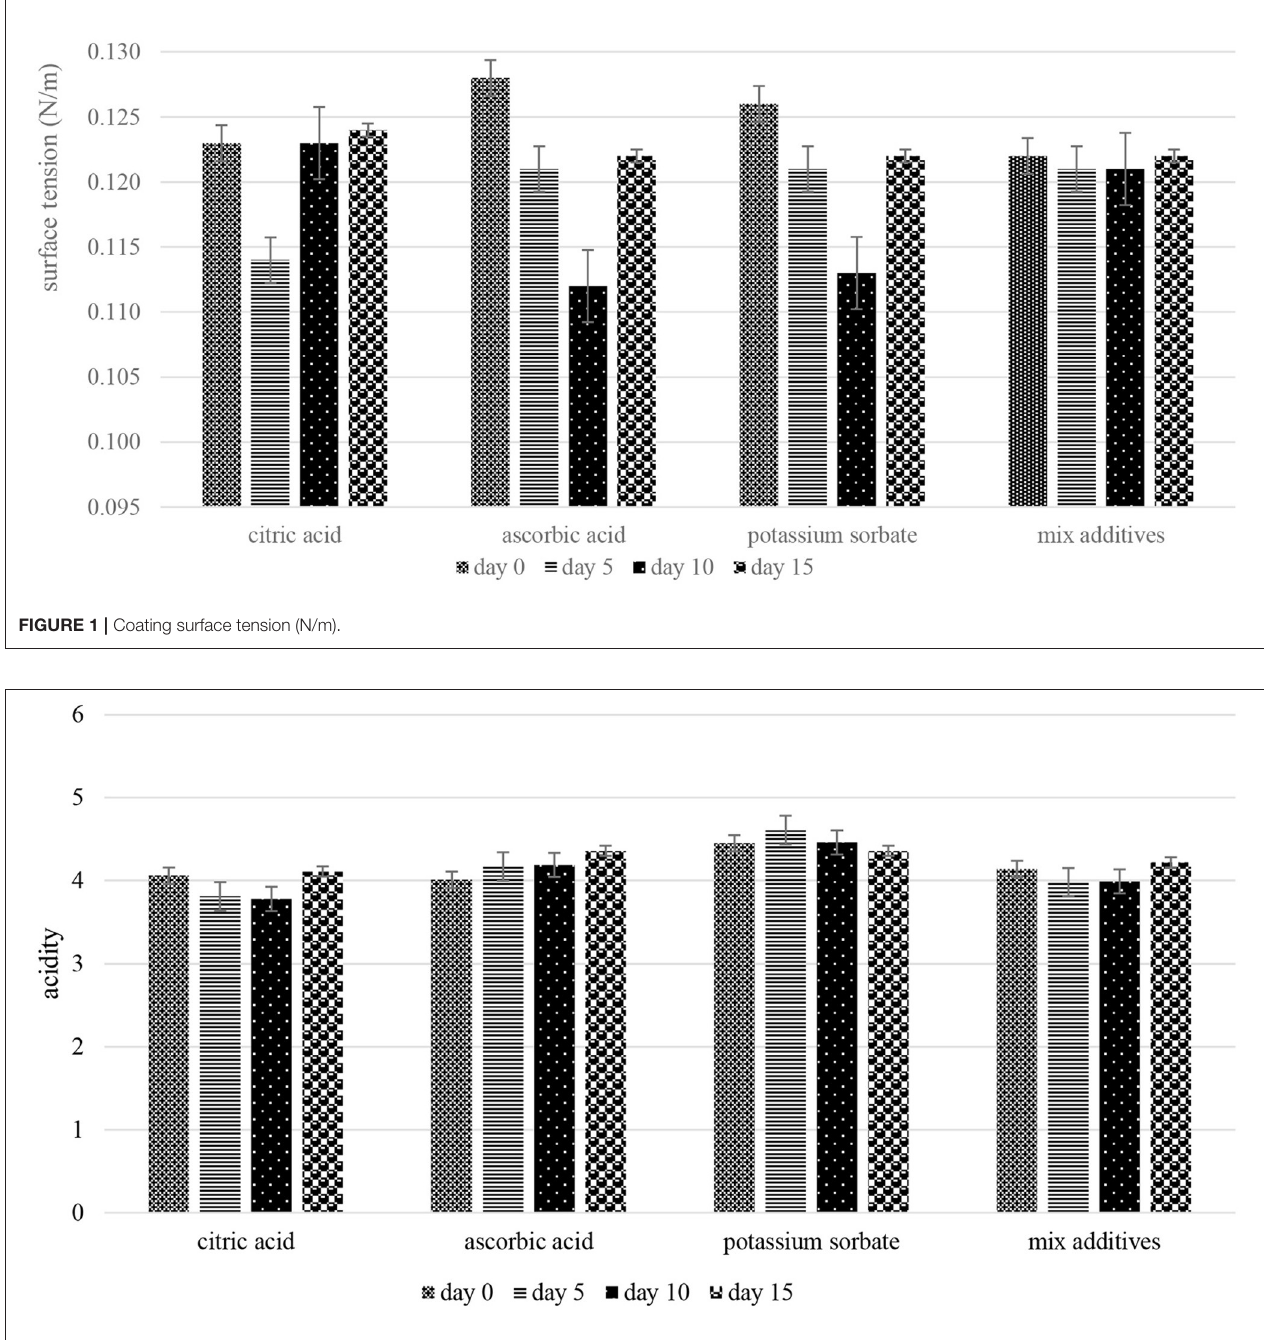
FIGURE 2 | Coating